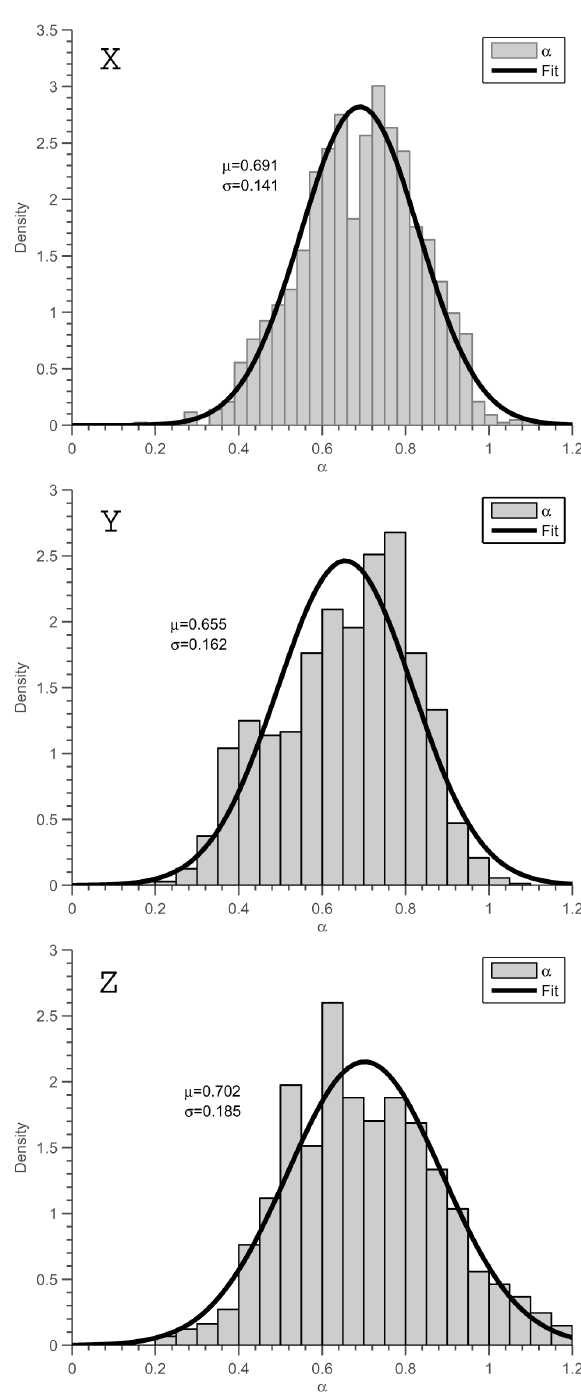
Fig. 4. Distributions of the fractal scaling exponent for quiet events, for all latitudes. These data are fitted to a normal distribution (solid black), with the mean and standard deviation given in the